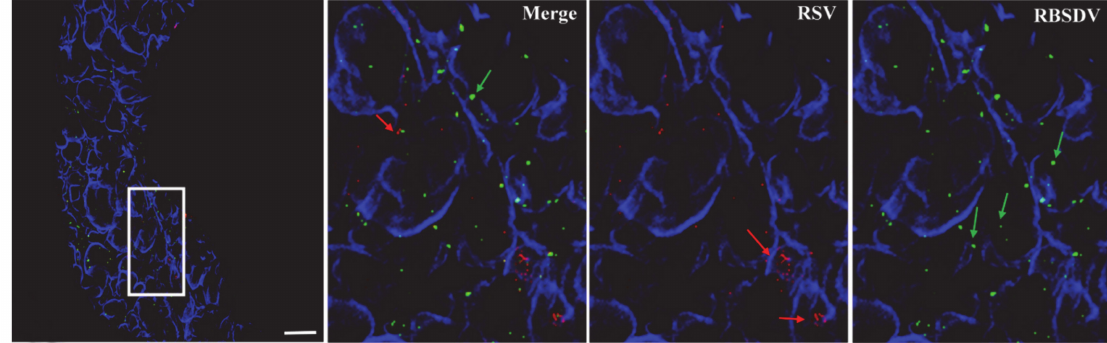
Figure 3. Localization of RBSDV and RSV in epithelial cells of midgut excised from nymphs after RSV first–RBSDV second access. The image on the right are the amplification of the white squares. RSV was detected using Alexa Fluor 549 (red), RBSDV using Alexa Fluor 488 (green), and Alexa Fluor 633 phalloidin was used to label actin (blue). Scale bar, 20 µ m.